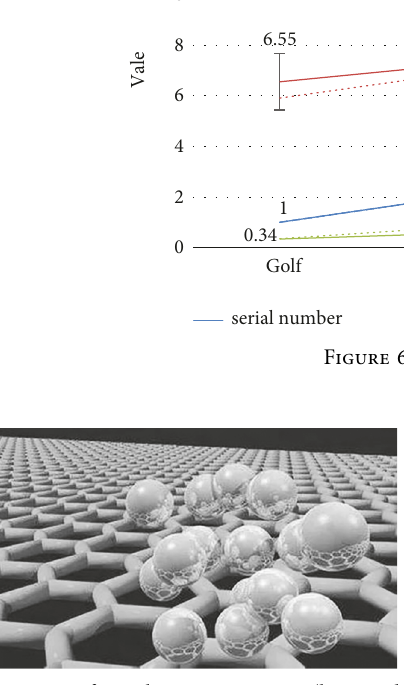
Figure 7: Prospect of graphene composites (https://alturl.com/ 5fuj7).